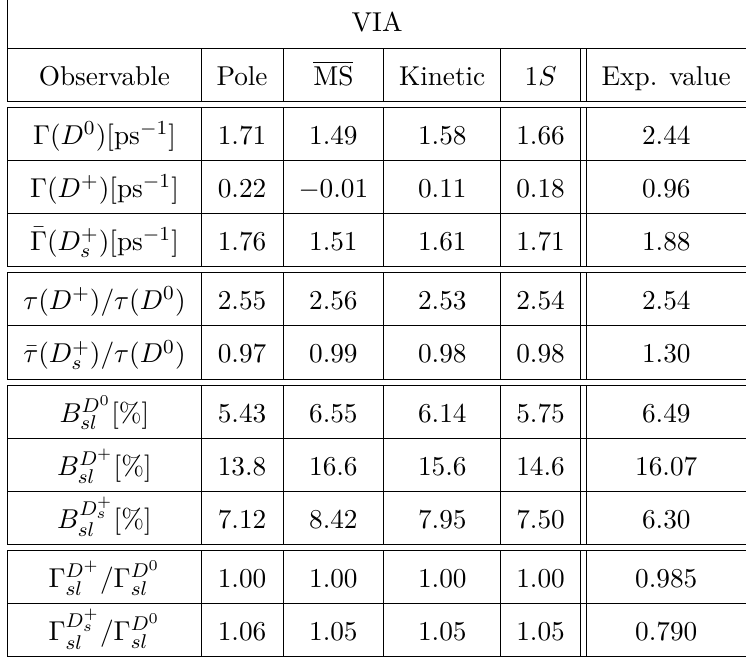
Table 13 . Central values of the charm observables in different quark mass schemes using VIA for the matrix elements of the 4-quark operators compared to the corresponding experimental values (last